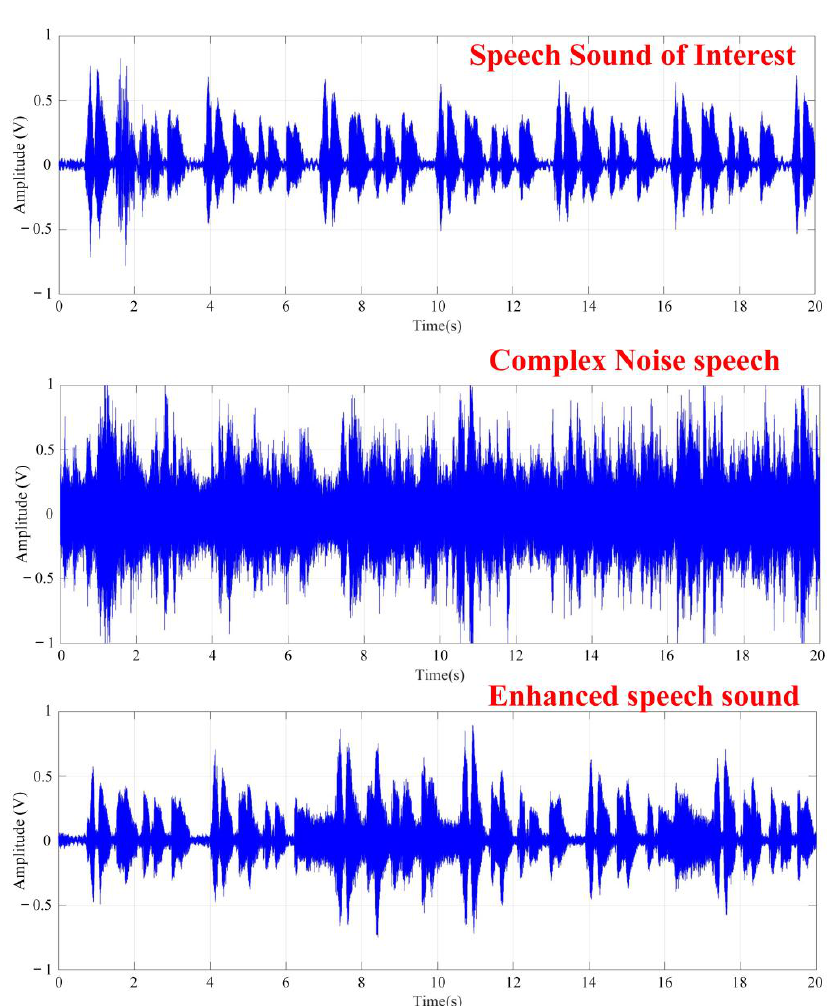
Figure 12. Speech sounds in moving interest targets, non-target speech sounds and filtered speech sounds in various noise environments.